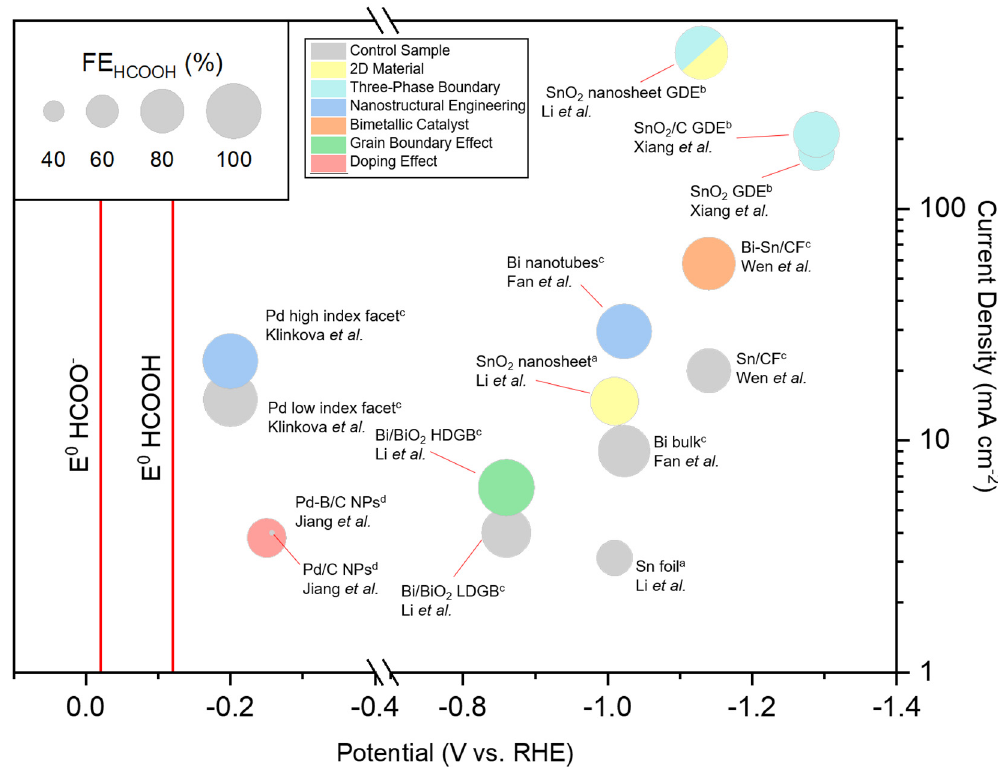
Figure 11. The summary of overpotentials, FE, and current densities previously reported for formic acid production. The electrolyte is indicated by the superscript letter after the catalyst name: a, 0.1 M NaHCO 3 ; b, 1 M KOH; c, 0.5 M KHCO 3 ; and d, 0.1 M KHCO 3 . Bi / BiO 2 HDBG = high-density-GB Bi / BiO 2 . Bi / BiO 2 LDBG = low-density-GB Bi / BiO 2 .